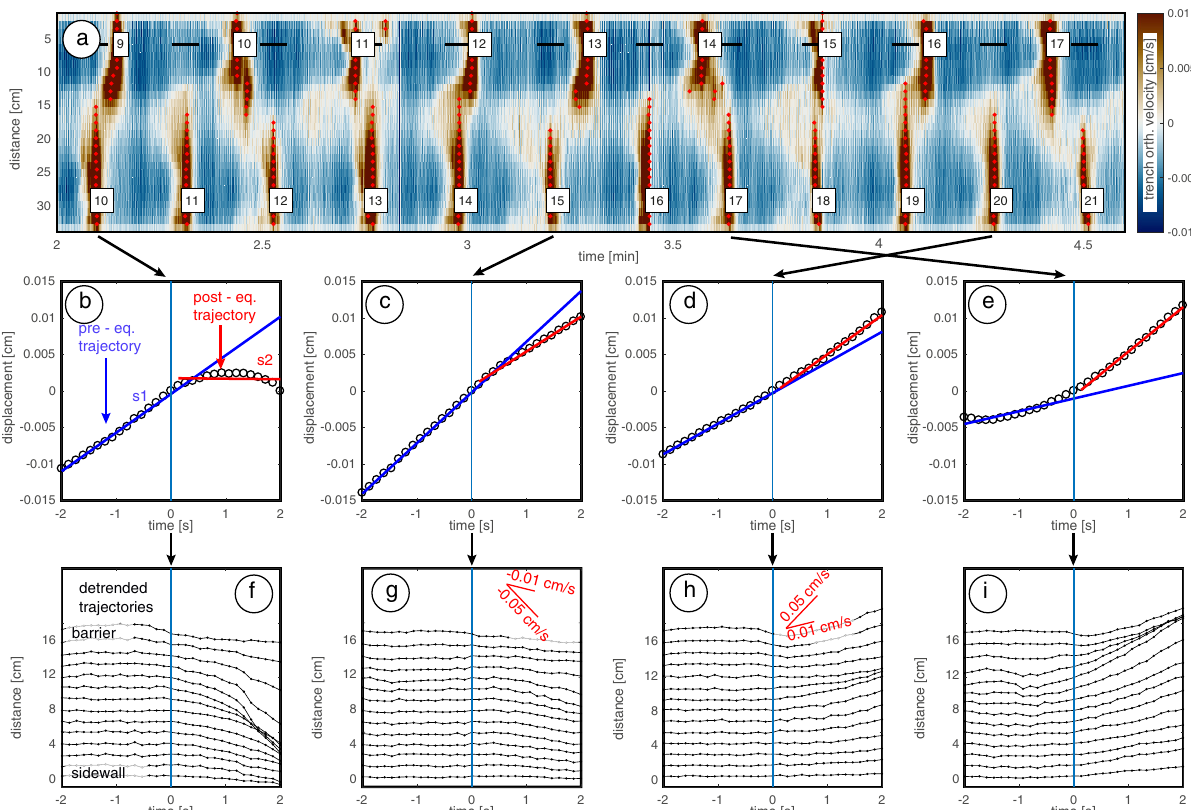
Fig. 2 Coseismic segment interaction. a Time evolution of the trench-orthogonal component of the velocity fi eld sampled along a section parallel to the trench and vertically intersecting the asperities mid-depth. Bluish and brownish colors correspond to landward and seaward velocities, respectively. Red dots represent velocity peaks, while black segments represent time windows of 4 s duration whose centers correspond to the velocity peak in the adjacent asperity. b – e Trajectories corresponding to single-pixel wide pro fi les at the location of the black segments shown in panel a . Blue and red segments represent pre- and post earthquake linear fi ts, respectively. Panels b – e are arranged in order of increasing Δ v. f – i For the same interactions we report time series of coastal measurement points on the receiver, detrended of the pre-earthquake velocity. Red lines report reference velocity